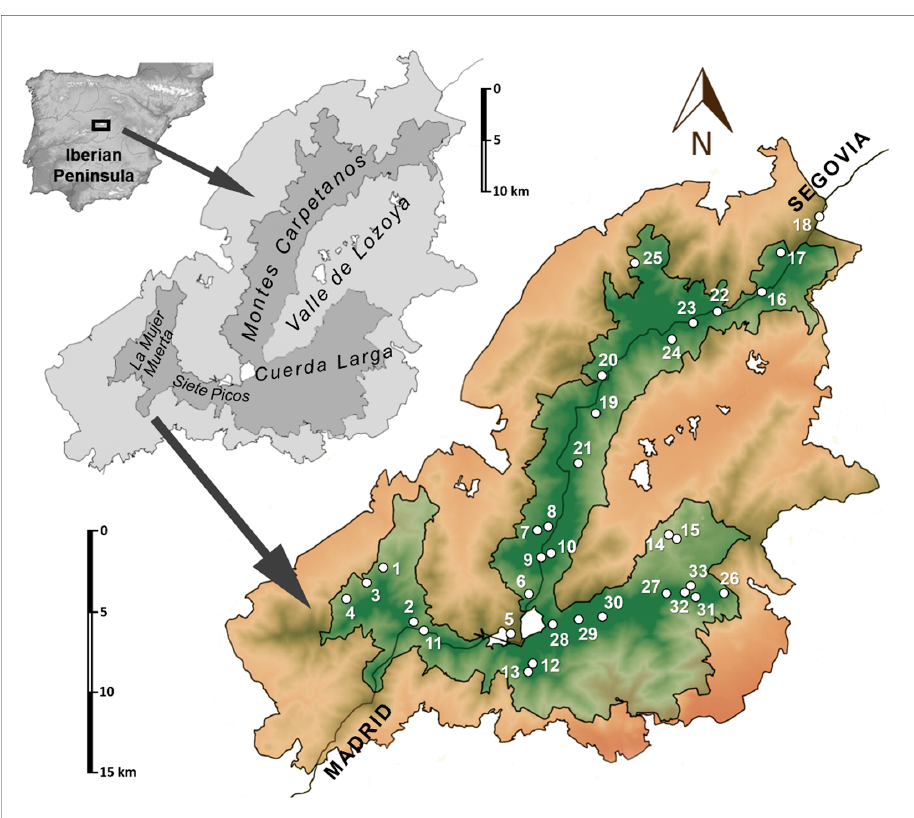
Figure 1. Sampling area in the Sierra de Guadarrama National Park, and locations of the subterranean sampling devices (SSD) used in the study of the Collembola.